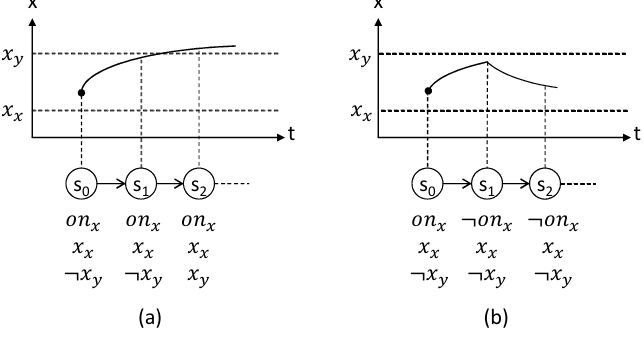
Figure 7: Typical behaviours when gene x is ON. (a) The expression level eventually increases. (b) Gene x becomes OFF before its level reaches x